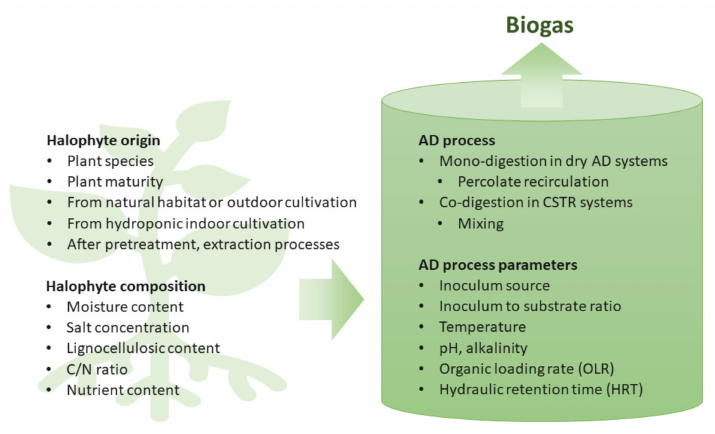
Figure 4. Factors affecting the anaerobic digestion (AD) of halophyte biomass. CSTR, continuous stirred tank